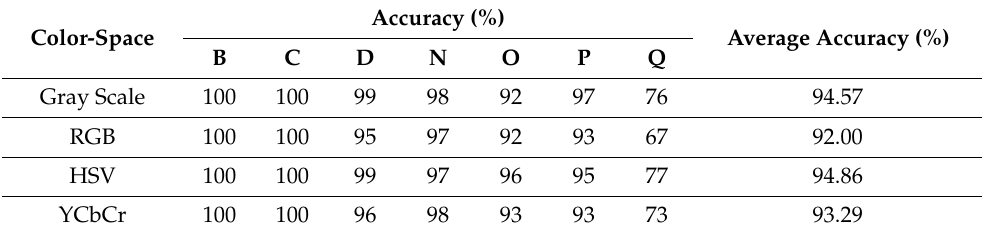
Table 10. Comparison of the results obtained using different color-spaces with changes in facial expression.